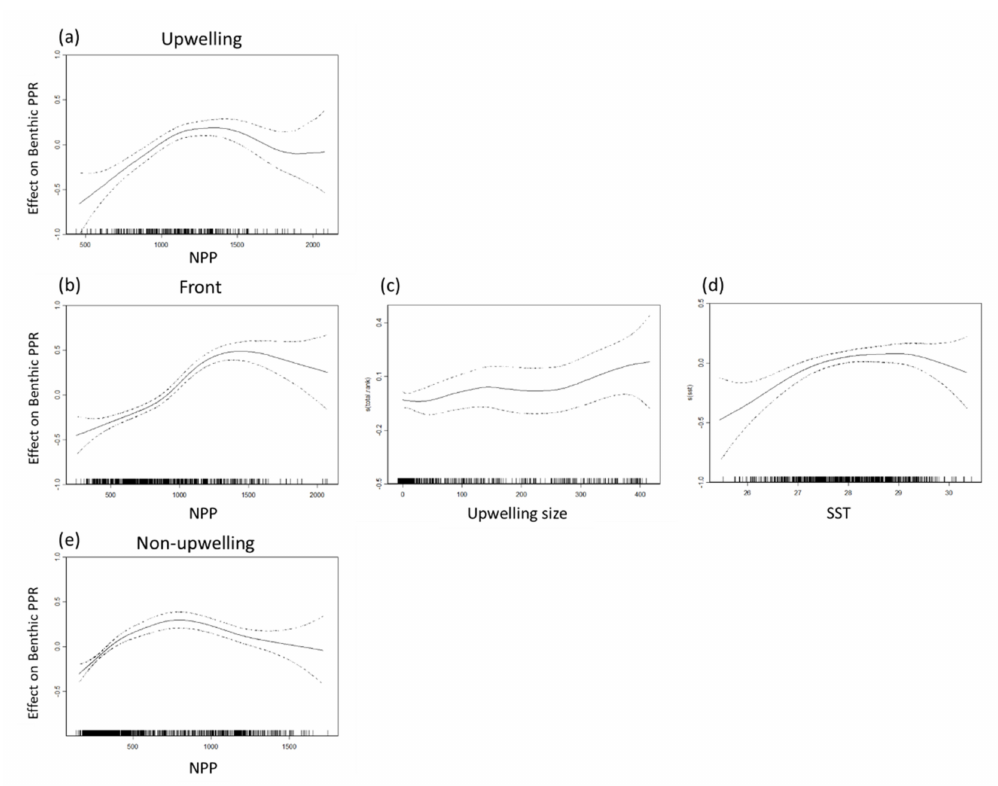
Figure 7. Partial residual plots of the effects of each factor on benthic primary production required (PPR) in the ( a ) upwelling habitat, ( b – d ) thermal front habitat, and ( e ) non-upwelling habitat.